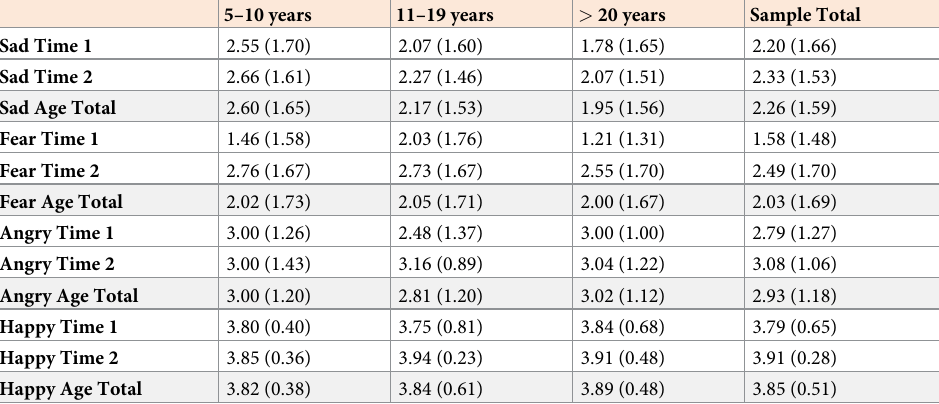
Table 2. Mean scores and (standard deviations) for emotion recognition task across age groups of participants with